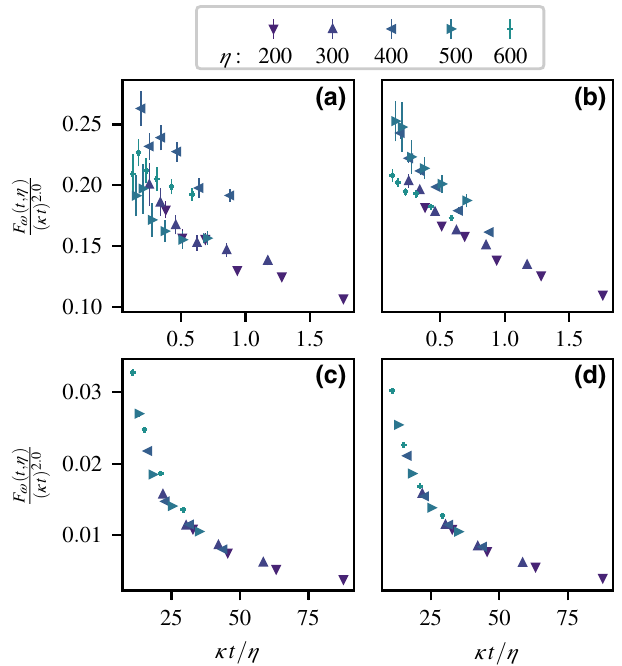
FIG. 5. Convergence of FI (21) with respect to the number of sampled trajectories N traj : (a),(c) N traj = 10 3 ; (b),(d) N traj = 10 4 . Parameters are the same as Fig. 4. The error bars are estimated from the variance of ten independent samplings, and are not shown if they are smaller than the data point size. The FI con- verges more slowly in the transient regime [(a),(b)] than in the long-time regime [(c),(d)], as represented by larger error bars in the former. By sampling a sufficient number of trajectories we reduce the sampling error in the FI, leading to the scaling collapse shown in Fig. 4.